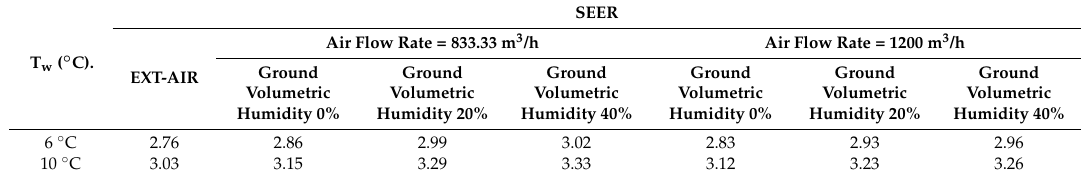
Table 10. SEER values with and without the use of geothermal probe (H = 3 m, L = 30 m, d = 0.5 m). SEER Air Flow Rate = 833.33 m 3 /h Air Flow Rate = 1200 m 3 /h T w ( ◦ C). Ground Ground Ground EXT-AIR Volumetric Volumetric Humidity 20% Humidity 0%